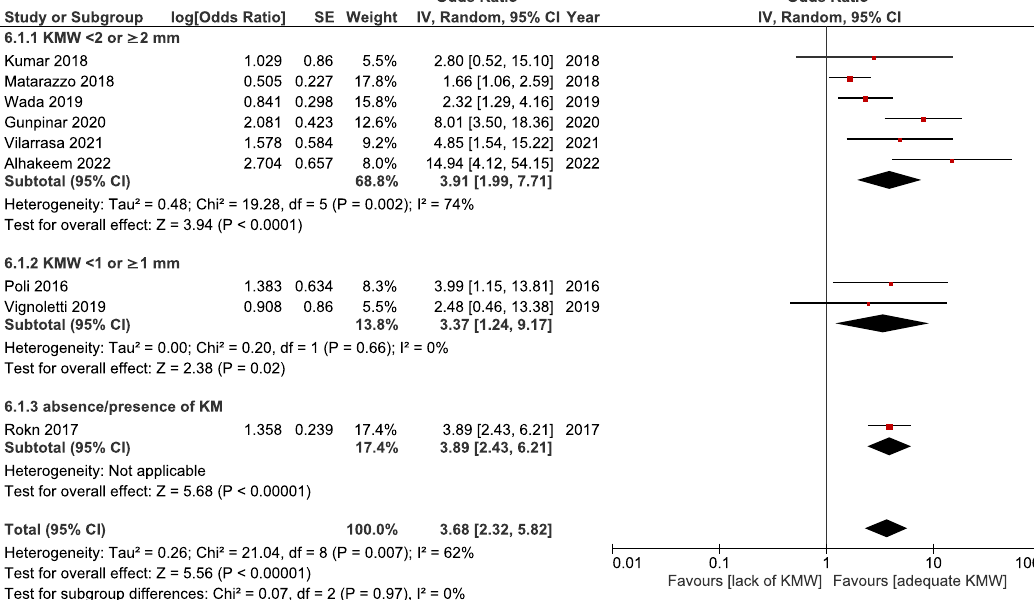
Figure 6. Result of the meta-analysis, including studies adjusting for other possible